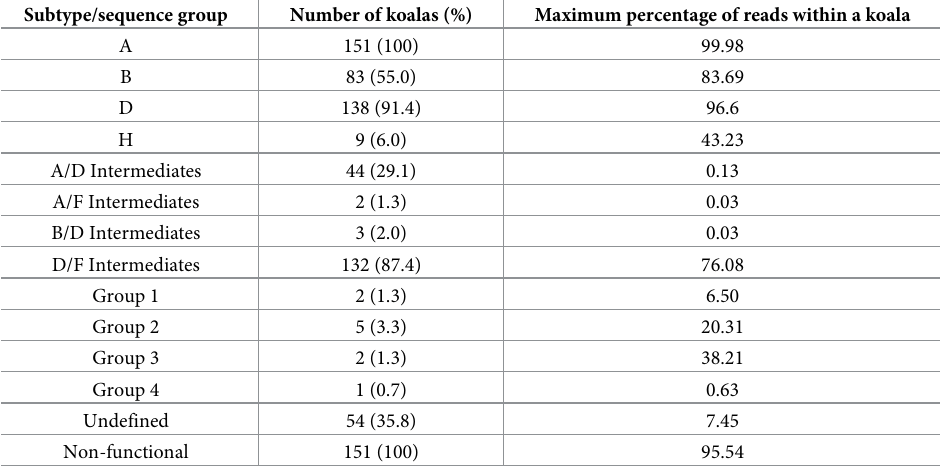
Table 1. Prevalence and relative abundance of KoRV